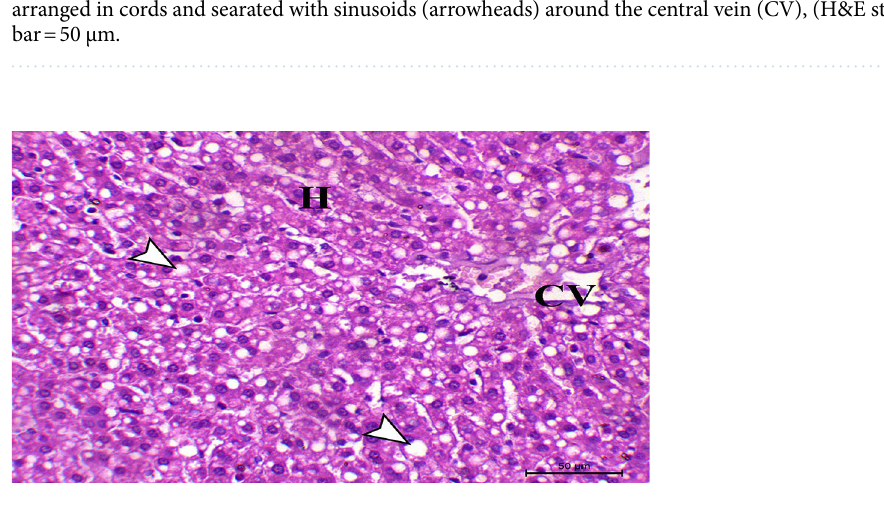
Figure 2. Photomicrograph of the hepatic section of HCD supplemented rabbit, showing marked hepatic vacuolation associated with fat cytoplasmic vacuoles (arrowheads) (CV indicates central vein and H indicates hepatocytes), (H&E stain), X200, bar = 50 µm.